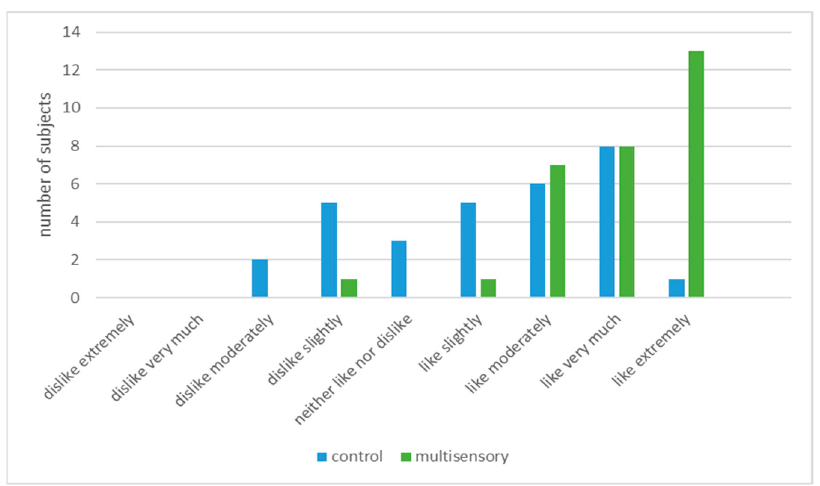
Figure 3. Liking of the test environment.